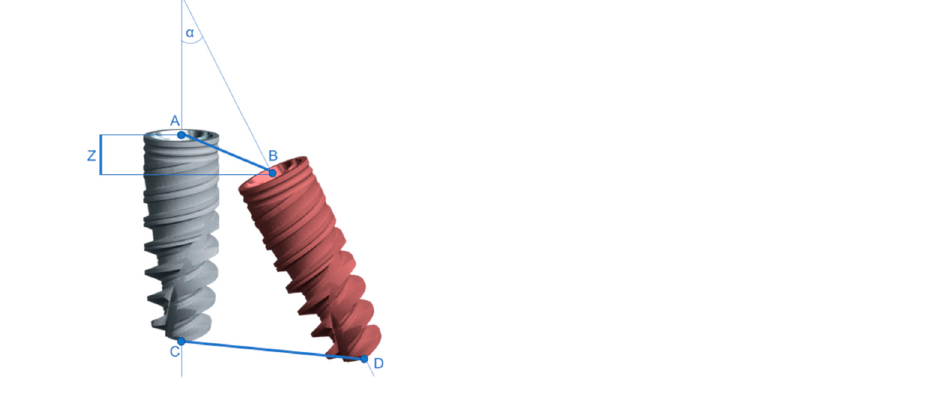
Figure 4. Graphic representation of the linear deviation parameters (coronal, apical, and vertical).